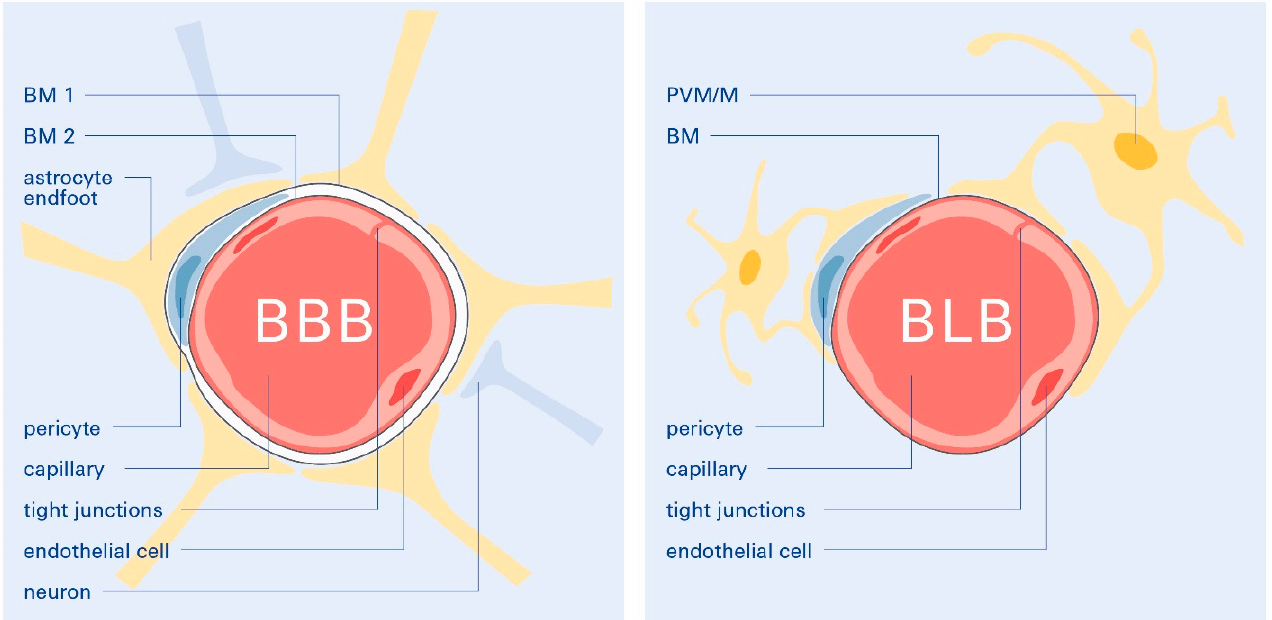
Figure 2. Illustration of the capillaries and cell types forming the BBB and BLB (cross‑sections). The BBB endothelium is embedded in a double basement membrane while, at the same time, accommo‑ dating the supporting pericytes. Within the CNS, BBB capillaries are covered by astrocytic end‑feet. The BLB endothelium is comparably surrounded by a basement membrane with pericytes ensheath‑ ing a simple basement membrane enclosing the capillaries. Perivascular resident macrophage‑like monocytes (PVM/Ms) coat the basement membrane surrounding the BLB endothelial cells. In both the BLB and BBB, tight junctions are present between the endothelial cells occulting the paravascular space. In BLB and BBB, the tight junctions are composed of similar proteins.